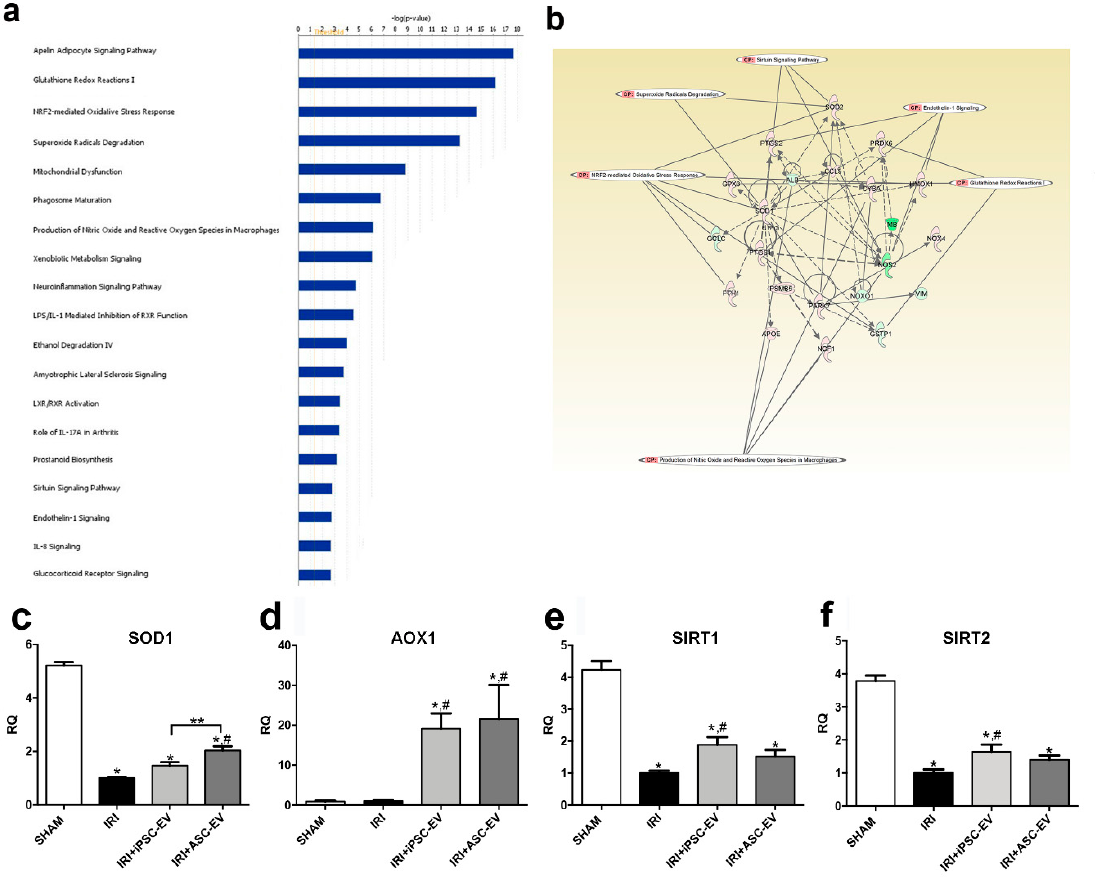
Figure 6. The protective e ff ect of iPSC-EV was related to the modulation of anti-oxidative stress genes in renal tissue. The analysis performed using Ingenuity pathway analysis (IPA) showed ( a ) the enriched biological processes associated with the modulated genes by iPSC-EV administration, indicated in the horizontal bars and ordered by their significance. ( b ) IPA network analysis generated by the modulated genes by iPSC-EV in renal tissue interconnected with relevant nodes involved in the most representative biological pathways associated with the EV treatment. qRT-PCR analysis of mRNA levels of ( c ) superoxide dismutase 1 (SOD1), ( d ) aldehyde oxidase-1 (AOX1), ( e ) significantly up-regulate sirtuin 1 (SIRT1), and ( f ) SIRT2 in renal tissue expressed as relative quantification (RQ) with respect to IRI (SHAM, n = 3; IRI, n = 3; IRI + iPSC-EV, n = 5; IRI + ASC-EV, n = 3). Data represent mean ± SEM (* indicates statistical di ff erence to SHAM group; # indicates statistical di ff erence to IRI group; ** indicates statistical di ff erence to IRI + iPSC-EV group; p < 0.05 assessed by one-way ANOVA followed by Tukey’s test).